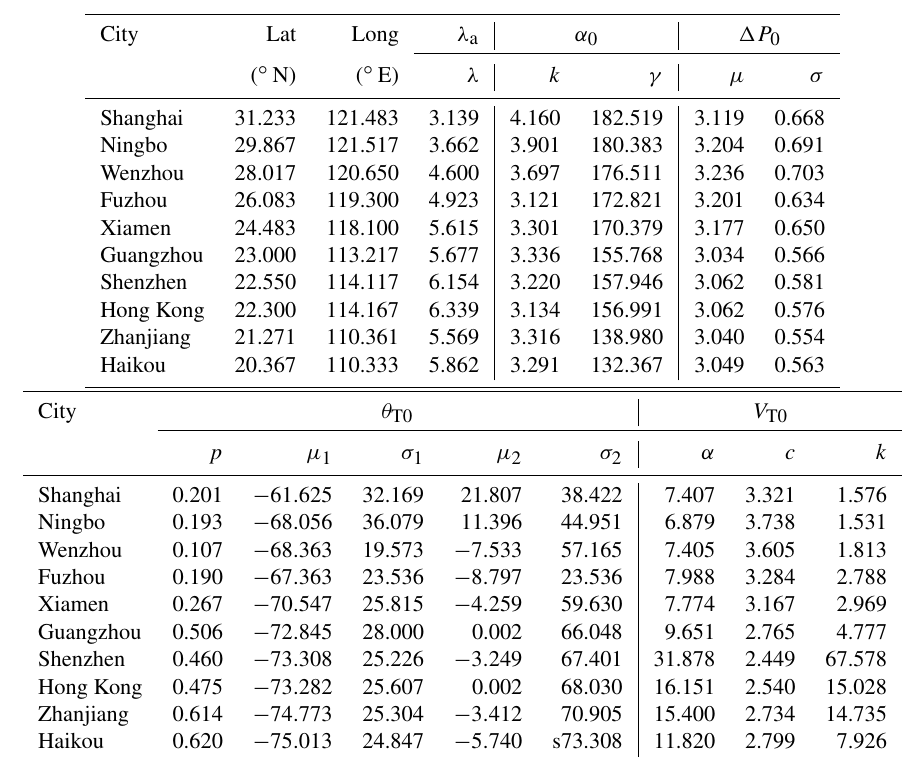
Table 2. Coefficients of PDFs for TC track genesis parameters.